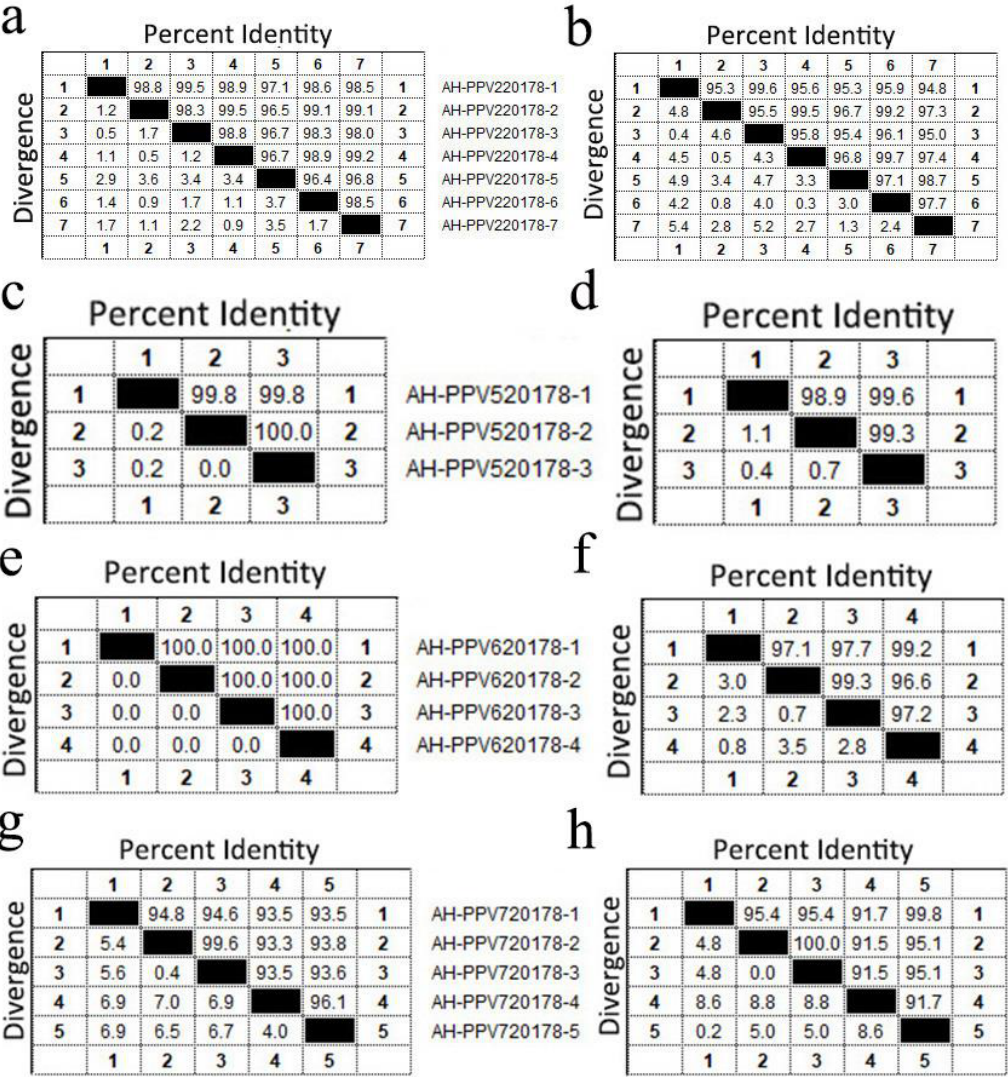
Figure 6. Porcine parvovirus isolated from sick pigs. Pairwise comparison based on the aa of NS protein ( a , c , e , g ) and VP protein of five species of PPV ( b , d , f , h ).